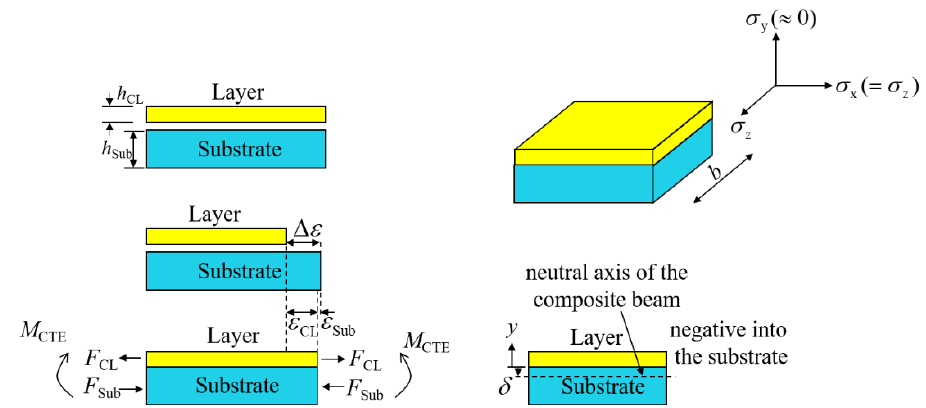
Figure 7. Schematic depiction of generation of pair of equal and opposite forces, and unbalanced moment due to deposition of some of the cladding layer on substrate surface.